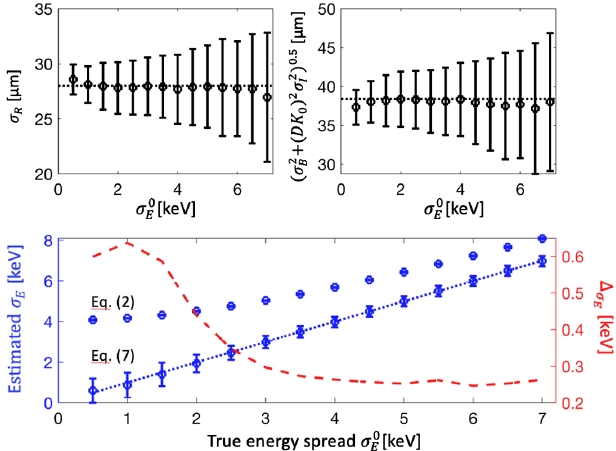
FIG. 2. Performance of the method based on the energy scan. Circles shows reconstructed mean values. Error bars give the standard deviation error. The red dashed curve presents the rms error of the reconstruction. Dotted blue curves show true values used for the